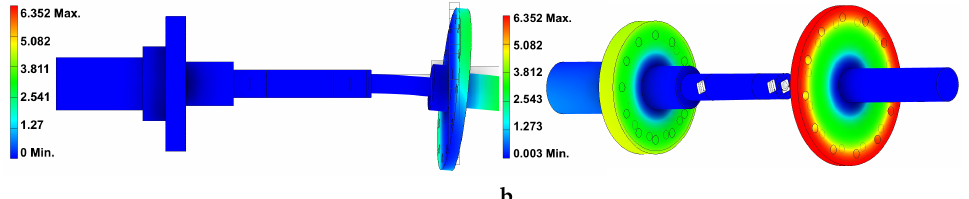
Figure 3. Analysis of the rotor dynamics for the BW BV35 turbocharger ( a ) first critical frequency at 623 Hz ( b ) second resonance frequency at 1413 Hz.